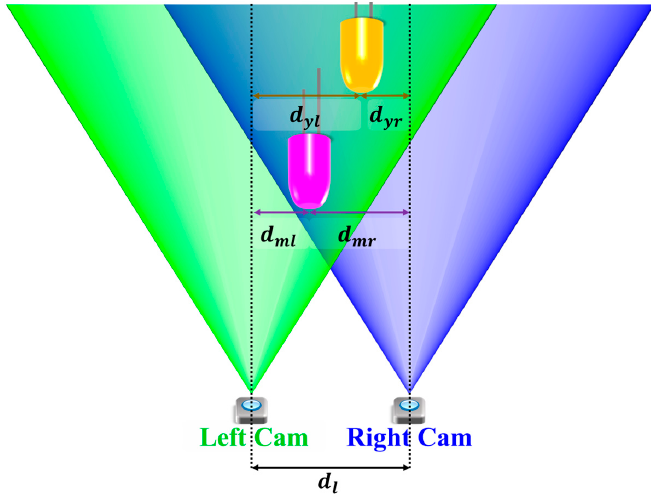
Figure 34. Timed shutter for multiple-camera frame rates.